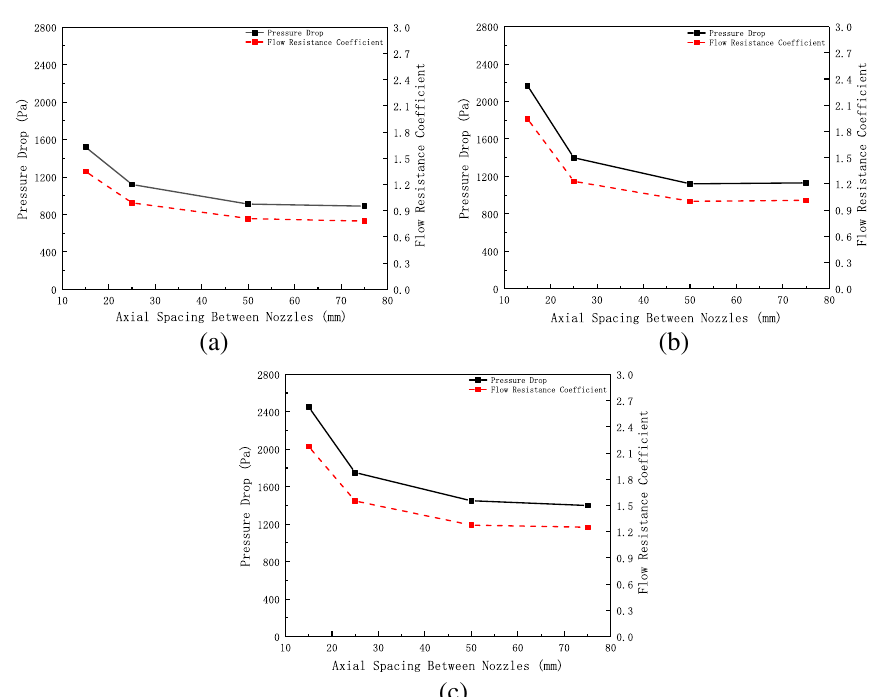
Fig. 16 Relationship between outer annulus pressure drop and flow resistance coefficient with axial spacing. Total number of nozzles is a 12, b 15, c